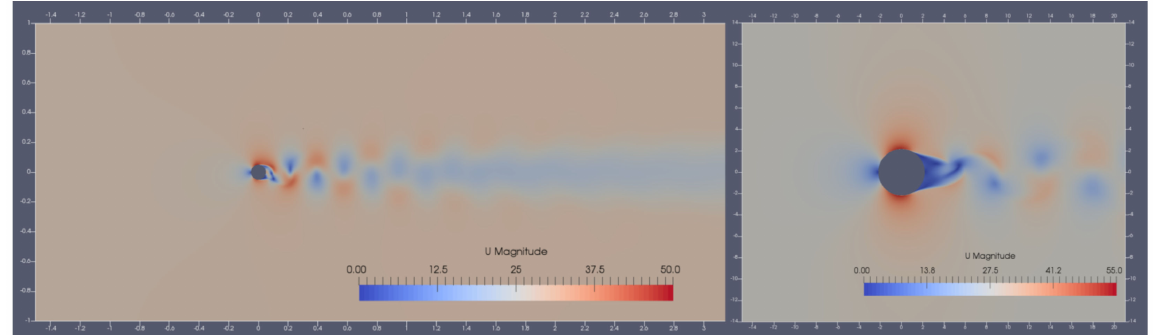
Figure 5. Schematic of the computational domain, mesh refinement regions and boundary conditions used in the isolated cylinder simulations.